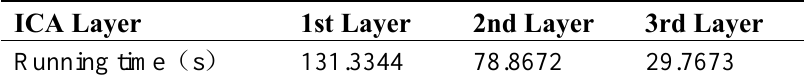
Table 1. The average training time of the natural images.